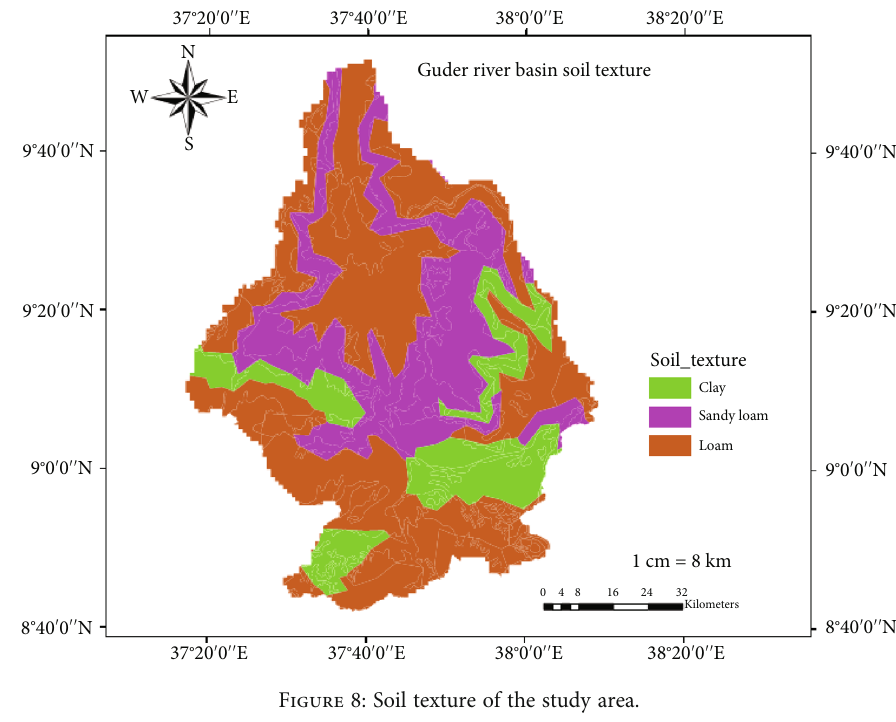
Figure 8: Soil texture of the study area.